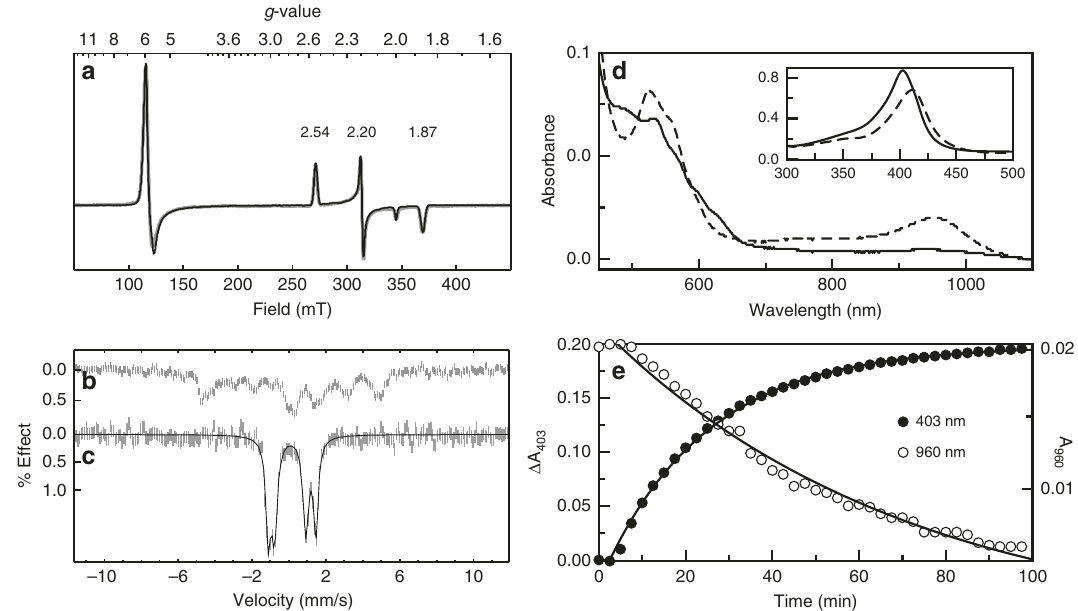
Fig. 3 Formation of a bis- Fe(IV) species in BthA. a EPR spectrum (9.642 GHz, 2 μ W) of 0.8 mM as-isolated Wt BthA recorded at 13 K. See main text for simulation parameters and corresponding species concentrations. b Mössbauer spectrum and simulations of as-isolated 57 Fe-enriched BthA recorded in an applied fi eld of 45 mT parallel to the incident γ -radiation, at a temperature of 4.2 K. See main text for simulation parameters. c After addition of 10 equiv. H 2 O 2 to the sample in b . d NIR spectra of Oxidized BthA (solid line) and H 2 O 2 treated (dashed line). After addition of H 2 O 2 , scans were collected every 2 min for 1.5 h (gray scans). The inset shows the shift in Soret from 403 to 411 nm. Over time, the feature at 960 nm begins to decay, and the Soret shifts back to the 402 nm position, suggesting reduction back to the initial, diferric state. e Decay of the bis- Fe(IV) monitored by the change in absorbance for the 402 and 960 nm feature vs. time. The rise of the Soret back to the 403 nm (closed circles) and the 960 nm decay (open circles) are shown as a function of time. Data were fi t to a single exponential rise/decay